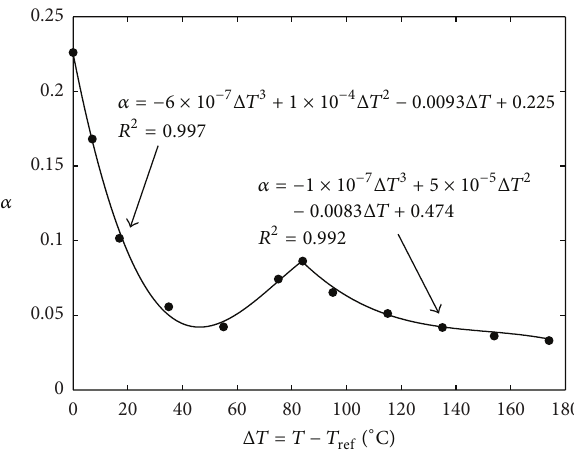
Figure 5: Variation of the identified model parameter 𝛼 versus temperature. Two different correlations are suggested due to a modification in the material microstructure of EVA for Δ𝑇 ∼ 80 ∘ C. The reference temperature is 𝑇 = − 35 ∘ C. R 2 represents the ref coefficient of determination of the